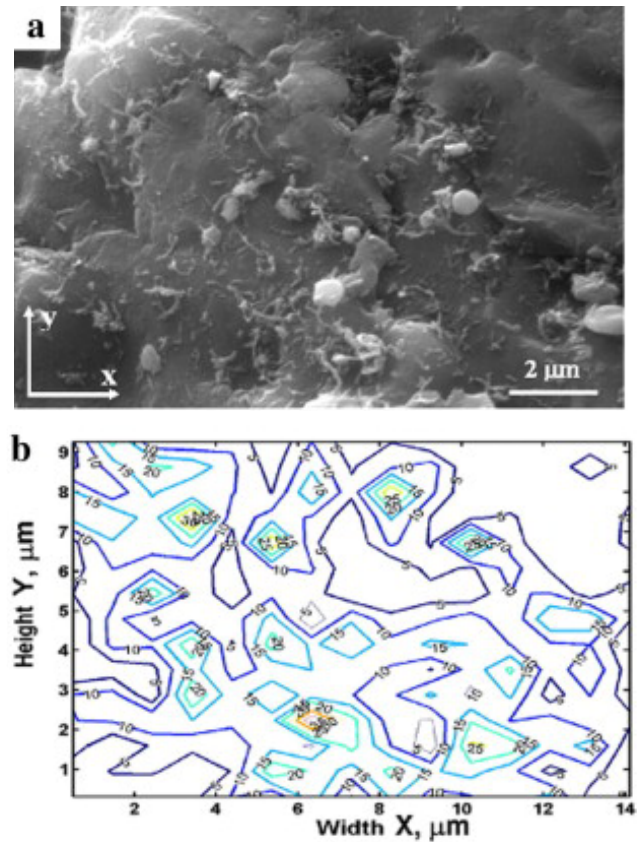
Figure 18. CNT dispersion in aluminum matrix. ( a ) SEM image; and ( b ) local area fraction contour map